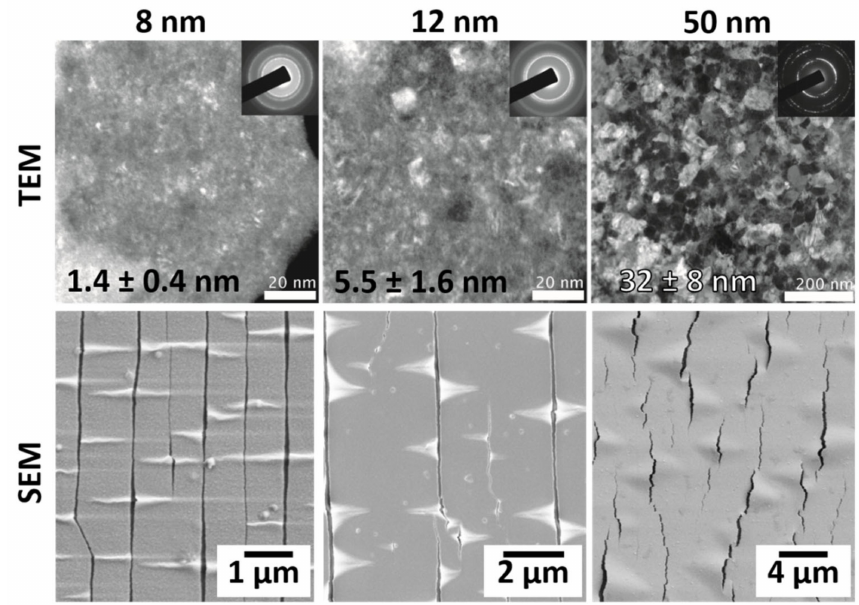
Figure 8. Electron beam evaporated Ti films (8, 12 and 50 nm thick) on PI have a transition in the crack morphology from long straight cracks to wavy, zig-zag cracks (bottom row) due to the increase in grain size (numbers in images) with increasing film thickness (top row) [52]. TEM images reprinted from Thin Solid Films, Vol. 589, M.J. Cordill and A.A. Taylor, Thickness effect on the fracture and delamination of titanium films, pp. 209–214, (2015) with permission from